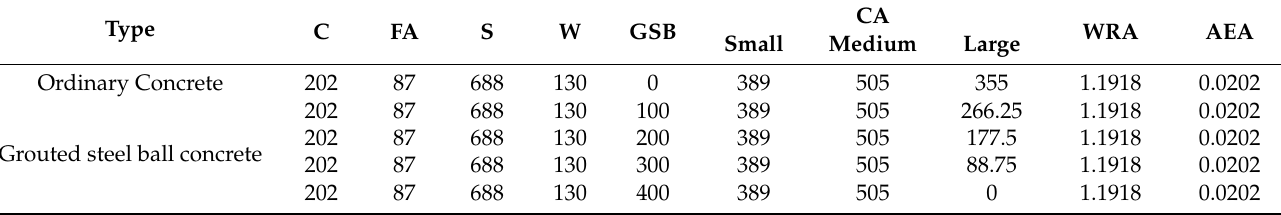
Table 5. Mix proportion of concrete modified by grouting steel balls (kg/m 3 ).